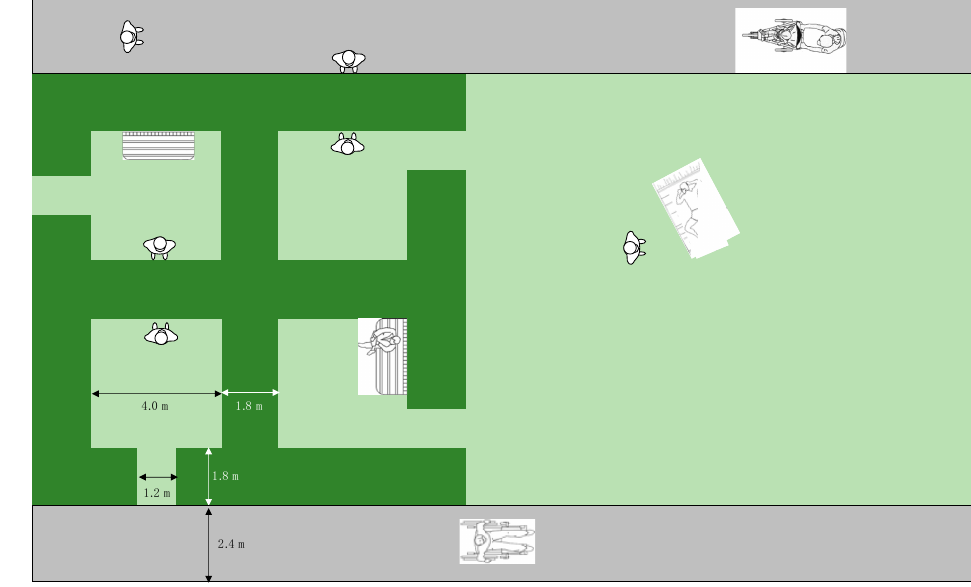
Figure 6. Design concept for value-adding to pocket parks by providing social pods (Adapted from Ref. [128]).